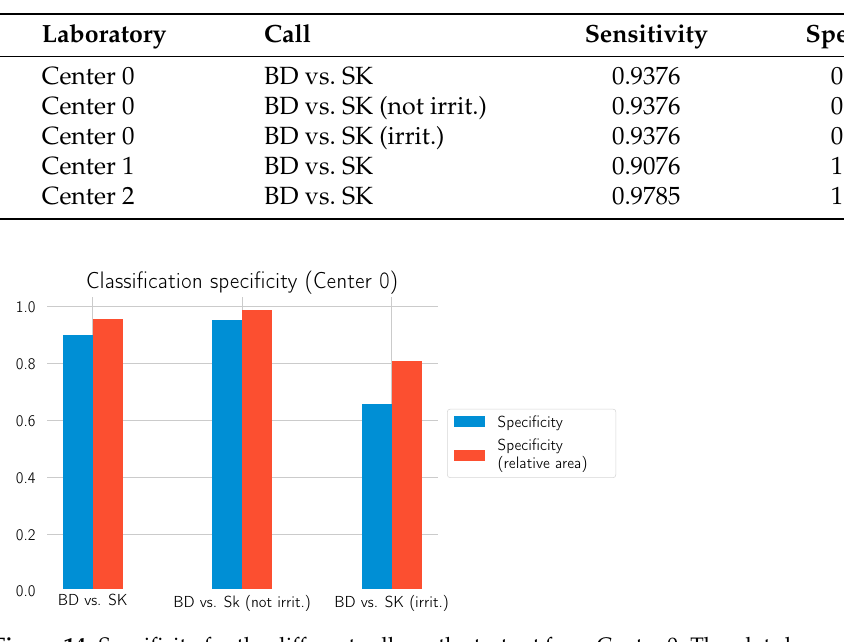
Figure 14. Specificity for the different calls on the test set from Center 0. The plot shows the specificity metric when using the first approach (blue) and the combined approach with the relative area